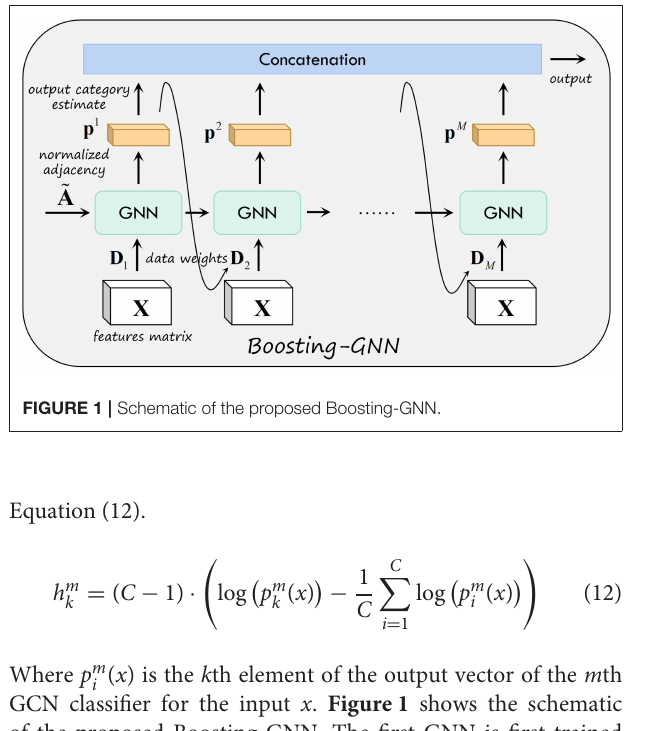
TABLE 1 | Datasets used for